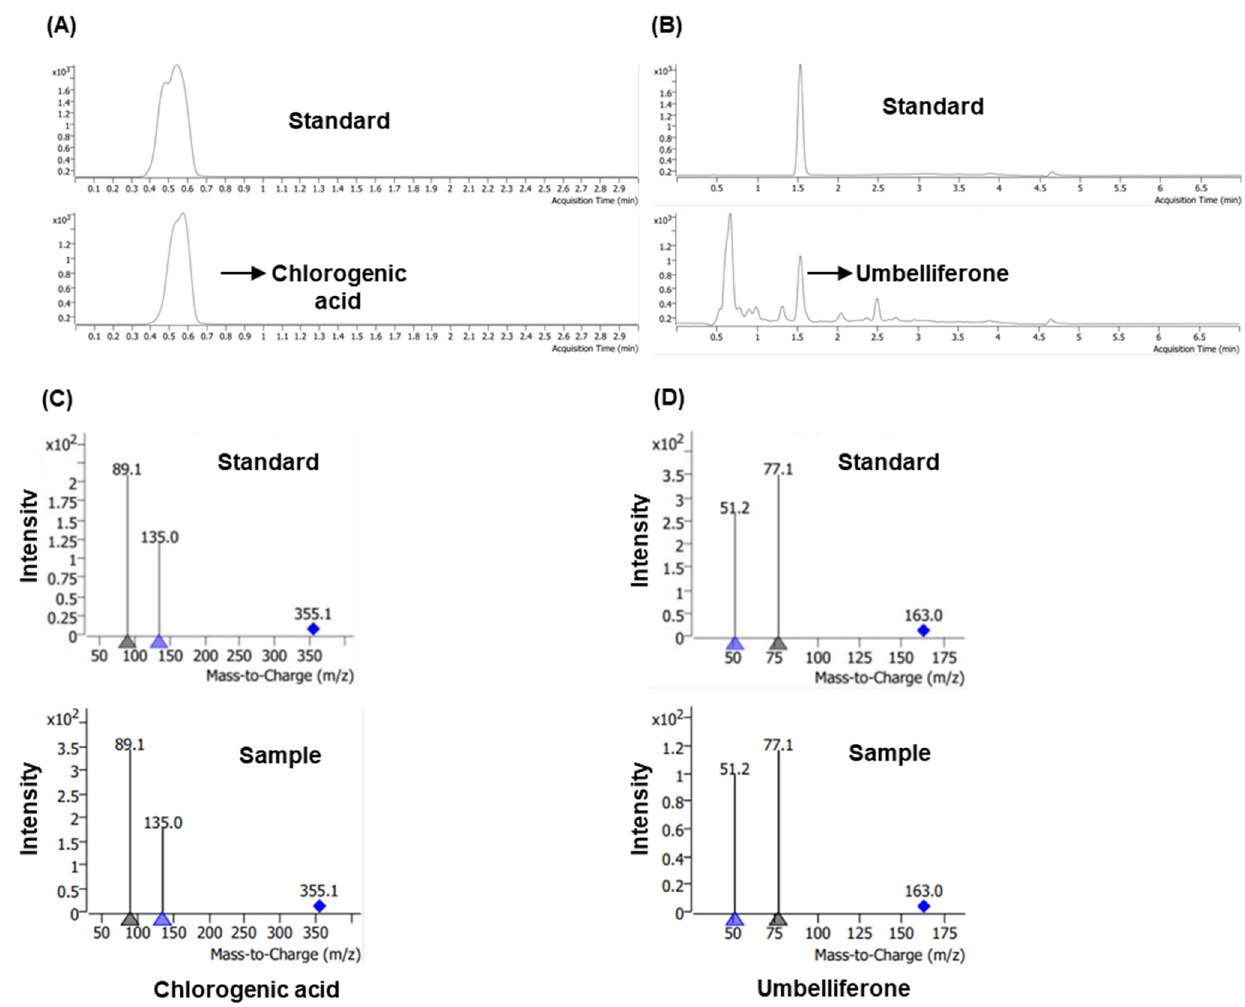
Figure 1. Concentration of chlorogenic acid and umbelliferone in Morus alba root extract (MARE). High-performance liquid chromatography (HPLC) chromatogram of ( A ) standard sample of chlorogenic acid and MARE ( B ) standard sample of umbelliferone and MARE. Product ion spectra of ( C ) chlorogenic acid standard (above) and sample (below) and ( D ) umbelliferone standard (above) and sample (below).